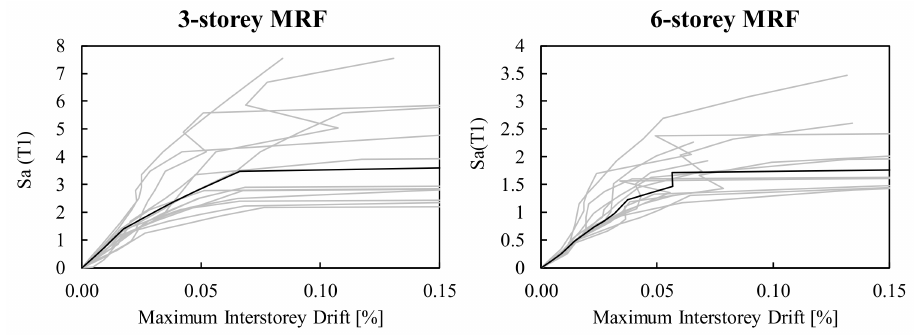
Figure 6. IDAs curves for examined